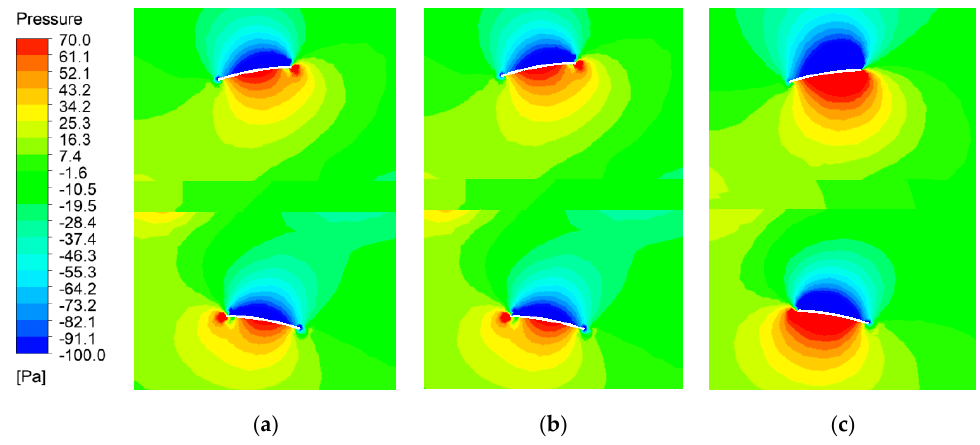
Figure 11. Pressure distribution of blade tip: ( a ) 0 m/s; ( b ) 2.5 m/s; ( c ) 4.0 m/s.